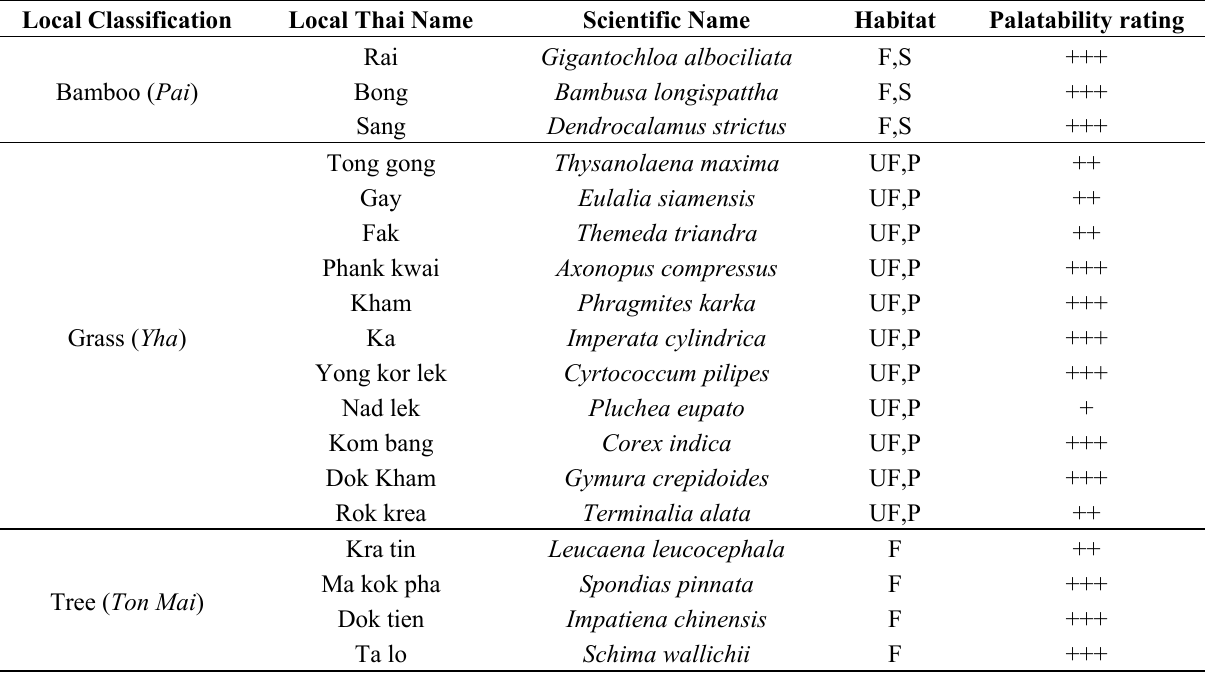
Table 2. List of main forage species in upland areas of northern Thailand with local classification, habitat types and palatability rating by ethnic minority groups. Source: Data obtained by individual interviews with 12 farmers and focus group discussions in Mae Klang Luang and Huai Phra